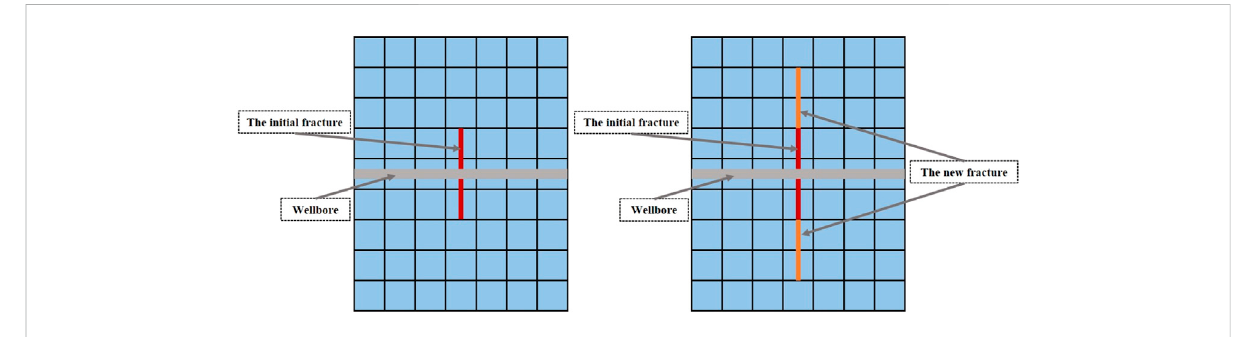
FIGURE 2 Schematic diagram of fracture propagation in the